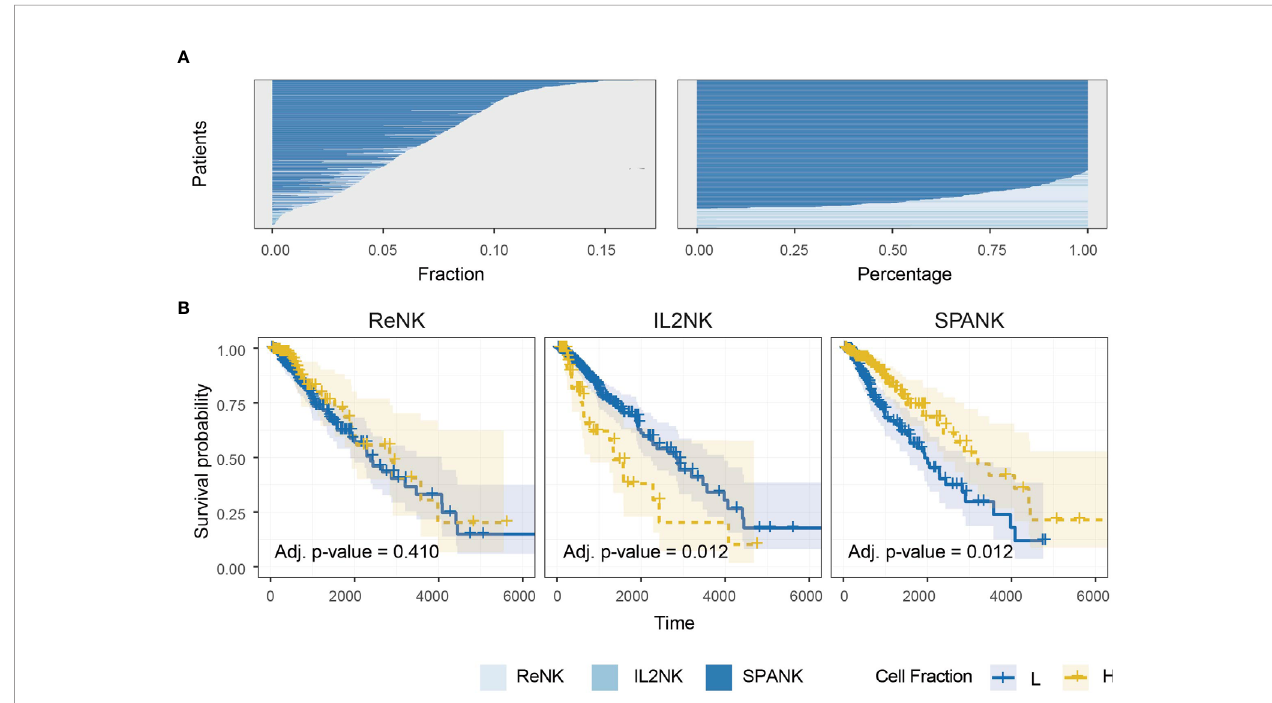
FIGURE 2 | Abundance of NK cell phenotypes and association with survival in the TCGA LGG dataset. (A) Abundance of NK cell phenotypes (fraction and percentage) for TCGA LGG cohort, the SPANK is the most abundant NK cell phenotype in LGG. (B) KM curves for all three NK cell phenotypes for TCGA-LGG; high tumor abundance of SPANK is associated with a bene fi cial LGG patient outcome compared to ReNK and